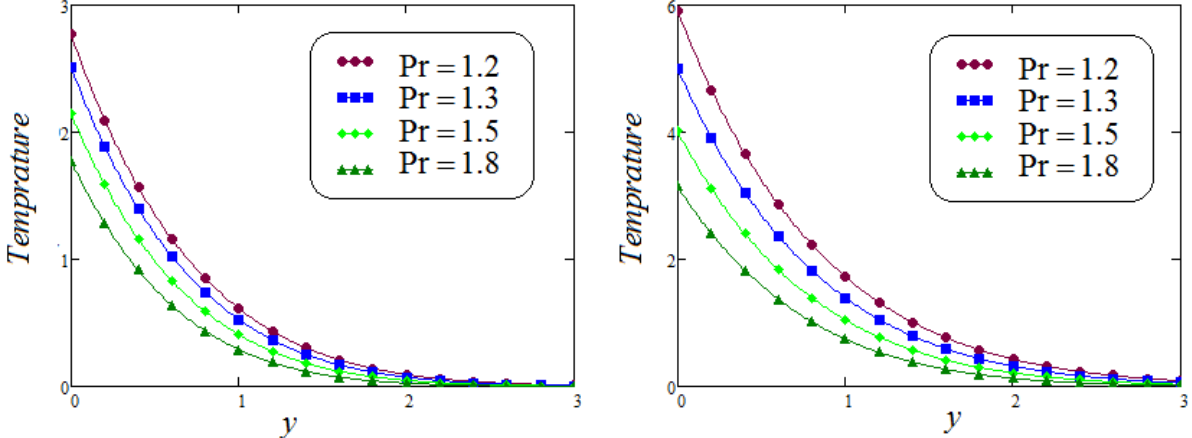
Figure 2. Temperature profile using different Pr values, when t = 0.9 and t =